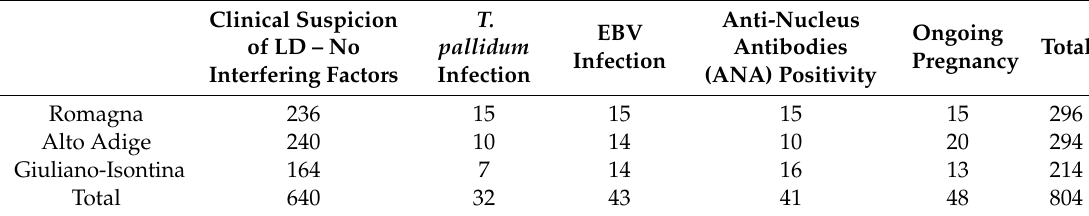
Table 1. pool composition.